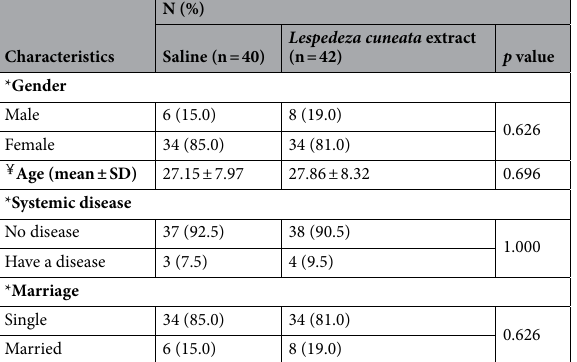
Table 2. Characteristics of the subjects in the two groups (n = 82). ￥ p values are determined by independent t test, * p values are determined by chi-square test & Fisher’s exact test ( p < 0.05). Values are means ± standard deviations.